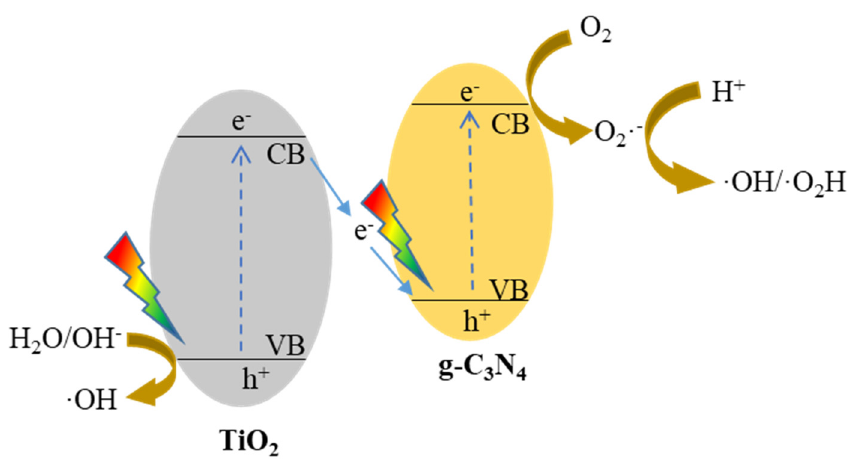
Figure 9. Proposed mechanism for the photodegradation of Rh B over 5-layer g-C 3 N 4 (0.5) / TiO 2 thin film.